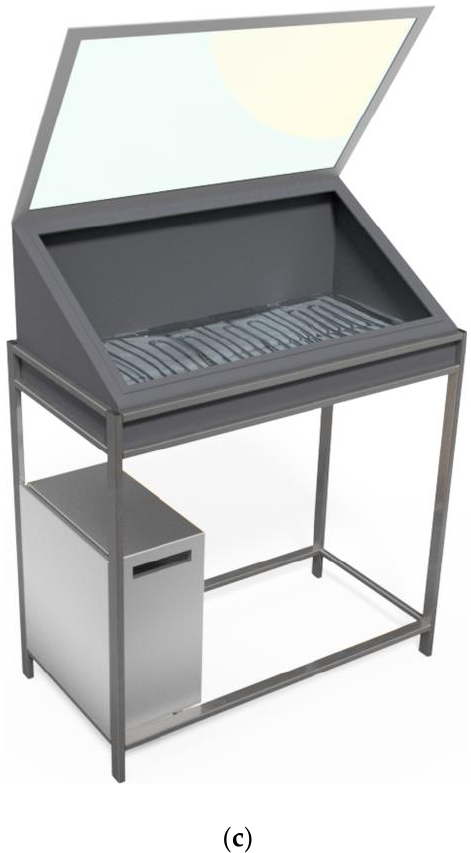
Figure 2. ( a ) Diagram of the solar still with the locations of the temperature sensors; ( b ) top view of the solar still; ( c ) 3-D model of the solar still. 1—feedwater tank; 2—pipe system; 3—shut-off valve; 4—three-way valve; 5—glass cover; 6—distillate trough; 7—distillate channel; 8—electric heater; 9—PCM; 10—thermal insulation; 11—distillate tank; 12—water level sensor; T—temperature. Subscripts: air—ambient air; b—absorber; dw—distilled water; f1, f2—humid air; fw—feedwater; gi—inner glass cover; go—outer glass cover; PCM—phase-change material; w—water. Table 1. Technical parameters of the measuring devices. Parameter Device Range Uncertainty Temperature of fluid RTD Pt1000